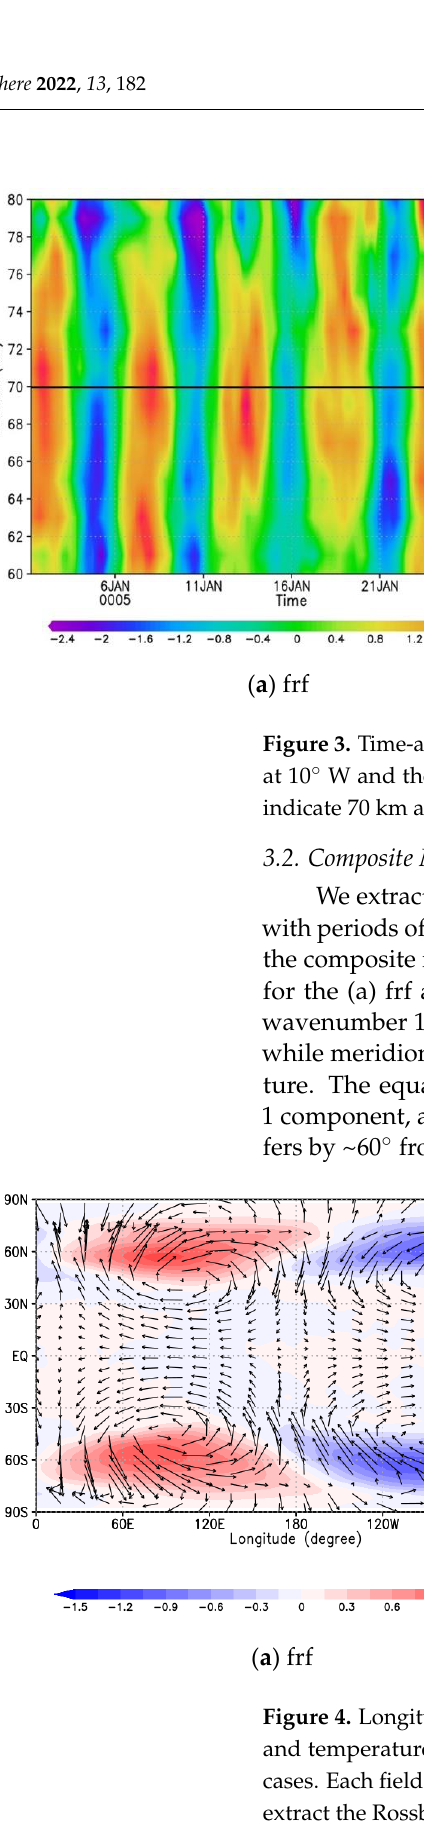
5 of 13 Figure 2. Longitude – time cross-sections of zonal wind (m/s) deviation from its time average from 1 January, 5th year at 70 km and the equator for the ( a ) frf and ( b ) control cases. Black arrows indicate periods of ~5 and ~4 Earth days for ( a ) and ( b ), respectively. The vertical structure of the Kelvin wave is also being investigated. Figure 3 shows the time-altitude cross-sections of the zonal wind deviation from its zonal and time aver- ages at 10° W and the equator for the (a) frf and (b) control cases. The black lines indicate